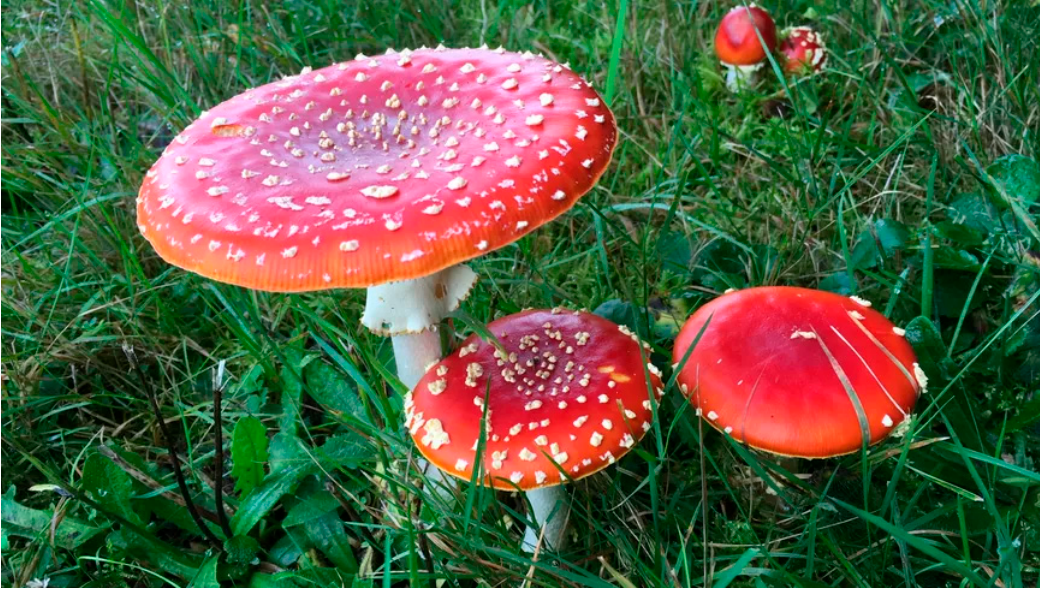
Figure 9. Amanita muscaria [190].